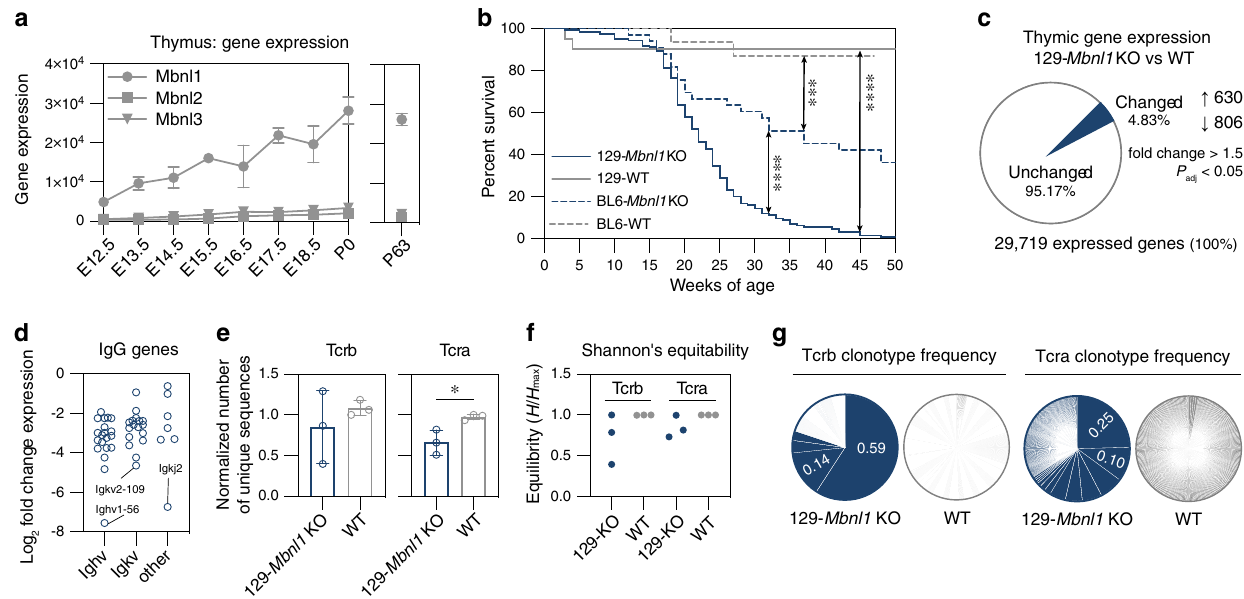
Fig. 1 Mbnl1 regulates thymic development. a Mbnl1 , Mbnl2 and Mbnl3 gene expression levels during thymus organogenesis and in the developed gland. RNA-seq was performed at embryonic (E) days: 12.5 ( n = 3), 13.5 ( n = 3), 14.5 ( n = 2), 15.5 ( n = 2), 16.5 ( n = 3), 17.5 ( n = 2), 18.5 ( n = 2) and postnatal days 0 (P0; n = 2) and 63 (P63; n = 3). Points connected by lines show mean expression ± standard deviation (SD). Data from embryonic and P0 thymi were obtained from GSE107910. b Survival curves for 129- Mbnl1 knockout (KO) ( n = 124, female/male ratio is 49/75), B6- Mbnl1 KO ( n = 33, 16/17), 129- wild type (WT) ( n = 21, 7/14) and B6-WT ( n = 21, 10/11). Signi fi cant differences between survival distributions were determined by Mantel – Cox (log-rank) test: *** P < 0.001; **** P < 0.0001. Median survivals are 22 and 37 weeks of age for 129- Mbnl1 KO and B6- Mbnl1 KO, respectively. There are no signi fi cant differences between females and males. c Gene expression changes in 129- Mbnl1 KO thymus. Pie chart represents the proportion of signi fi cantly altered genes (blue) to all detected genes (gray) in 129-Mbnl1 KO ( n = 3) compared to WT ( n = 3) RNA-seq samples. d Scatter plot represents 44 downregulated genes encoding immunoglobulin heavy ( Ighv ; 20 genes), kappa ( Igkv ; 17 genes) and other (7 genes) chains. Each dot represents a signi fi cantly changed gene by DESeq2 analysis. The most affected gene for each group is indicated. e Reduction of the TCR repertoire detected by Mbnl1 KO RNA-seq. Bar graph shows number of unique Tcrb and Tcra sequences normalized to the unique mapped read count ± SD. Signi fi cant difference was determined by two-tailed t-test: * P = 0.027. f Tcrb ( n = 3) and Tcra ( n = 3) repertoire diversity re fl ected by Shannon ’ s equitability where 1 equals complete equivalency. g Pie charts demonstrate representative Tcrb and Tcra clonotype frequencies in 129- Mbnl1 KO and WT thymic RNA-seq. Gray areas represent unique clones from the total clone count. Source data are provided as a Supplementary Data 1 fi